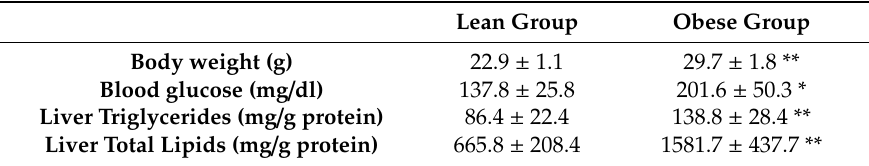
Table 3. Parameters of high-fat diet-induced obese